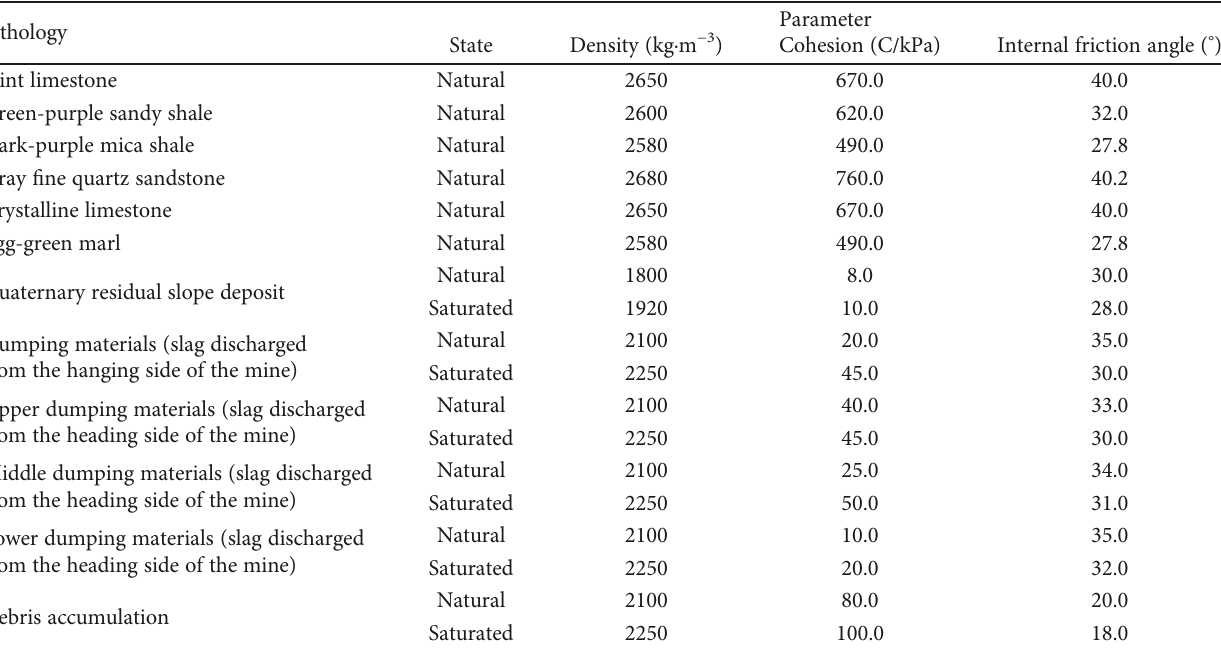
Table 1: Strength parameters of Dump II.